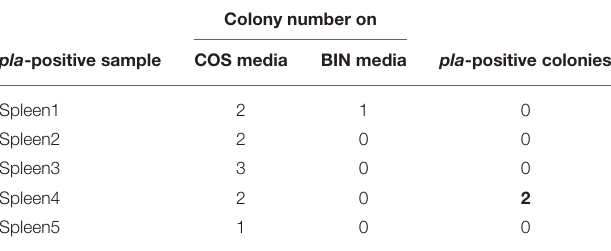
TABLE 1 | Pla -positive colonies obtained from spleen samples. Colony number